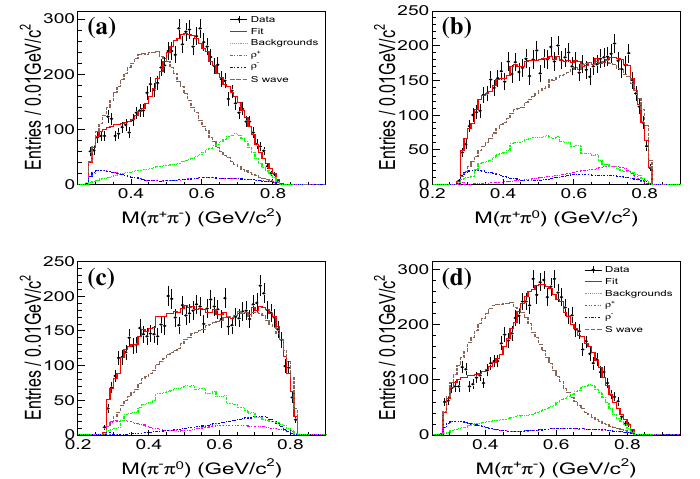
Figure 1. Comparison of the invariant mass distributions of (a) π + π − , (b) π + π 0 , (c) π − π 0 , and (d) π 0 π 0 between data (dots with error bars) and the fit result projections (solid histograms). The dotted, dashed, dash-dotted, and dash-dot-dotted histograms show the contributions from background, S wave, ρ − , and ρ + ,